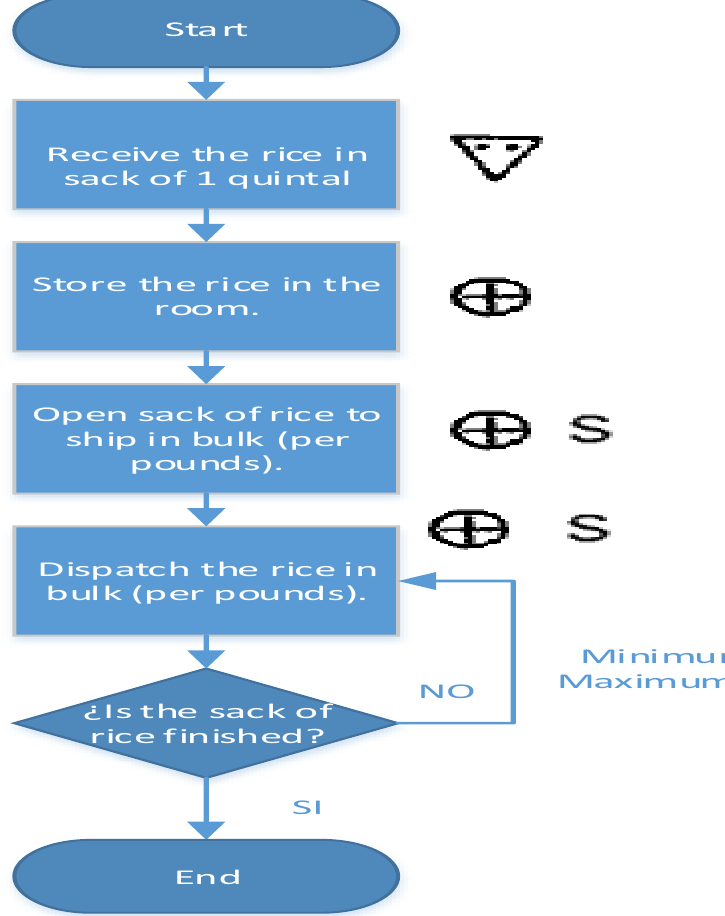
Figure 2: Food circulation diagram of piled rice in the "Las Manuelas"